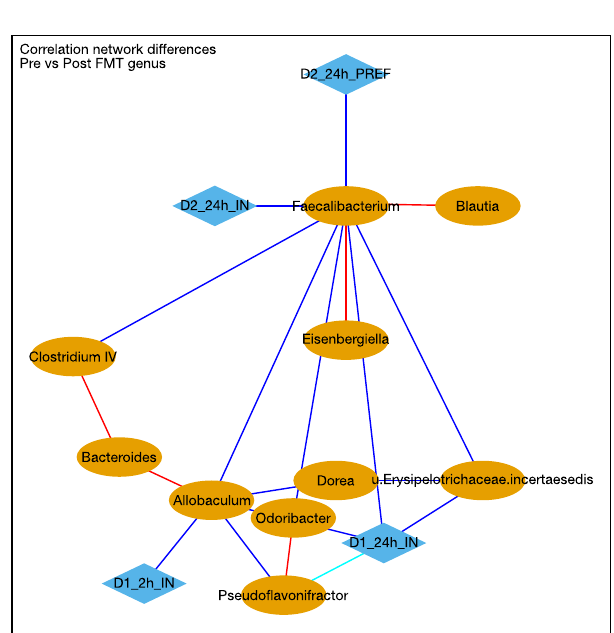
Fig. 8 | Correlation Differences in mice after colonization. Blue: shift from positivetonegative(Pre-FMTtopost-FMT),Red:shiftnegativetopositive(Pre-FMT to post-FMT), Cyan: loss in negative correlation from Pre-FMT to post-FMT, which means post-FMT the negative correlation between the 2 nodes that was present pre-FMT is now not present. Pink nodes are microbial genera. D1_2hI_IN: binge intake day 1, D1_24h_IN: 24hour preference day 1, D2_24h_IN: day 2 intake, D2_24h_PREF: 24h preference day 2, Pink nodes are microbial